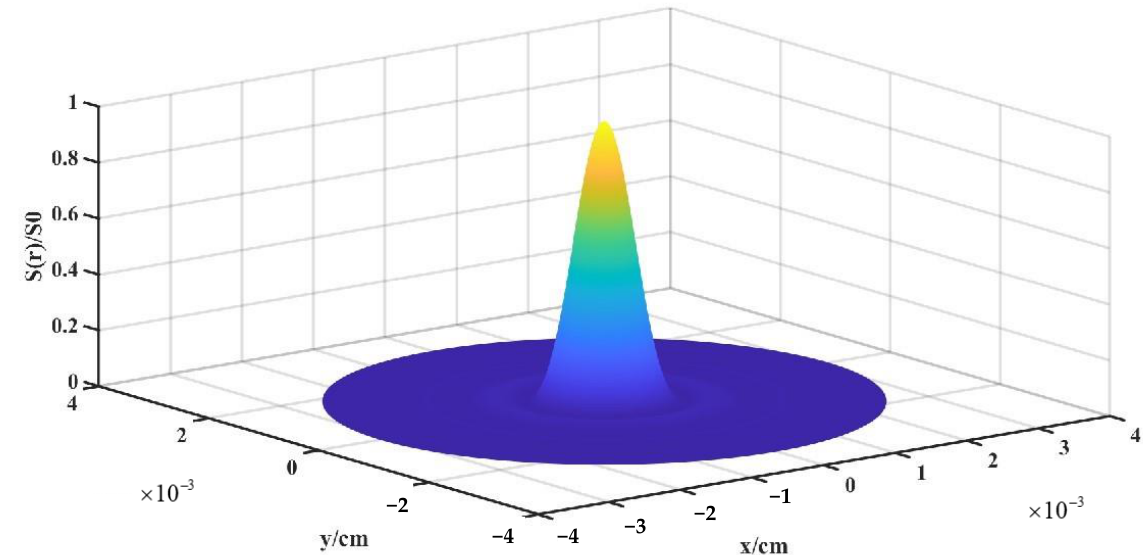
Figure 3. Intensity distribution of Fraunhofer diffraction of circular aperture. Table 1. Intensity distribution of each ring of the diffraction pattern.